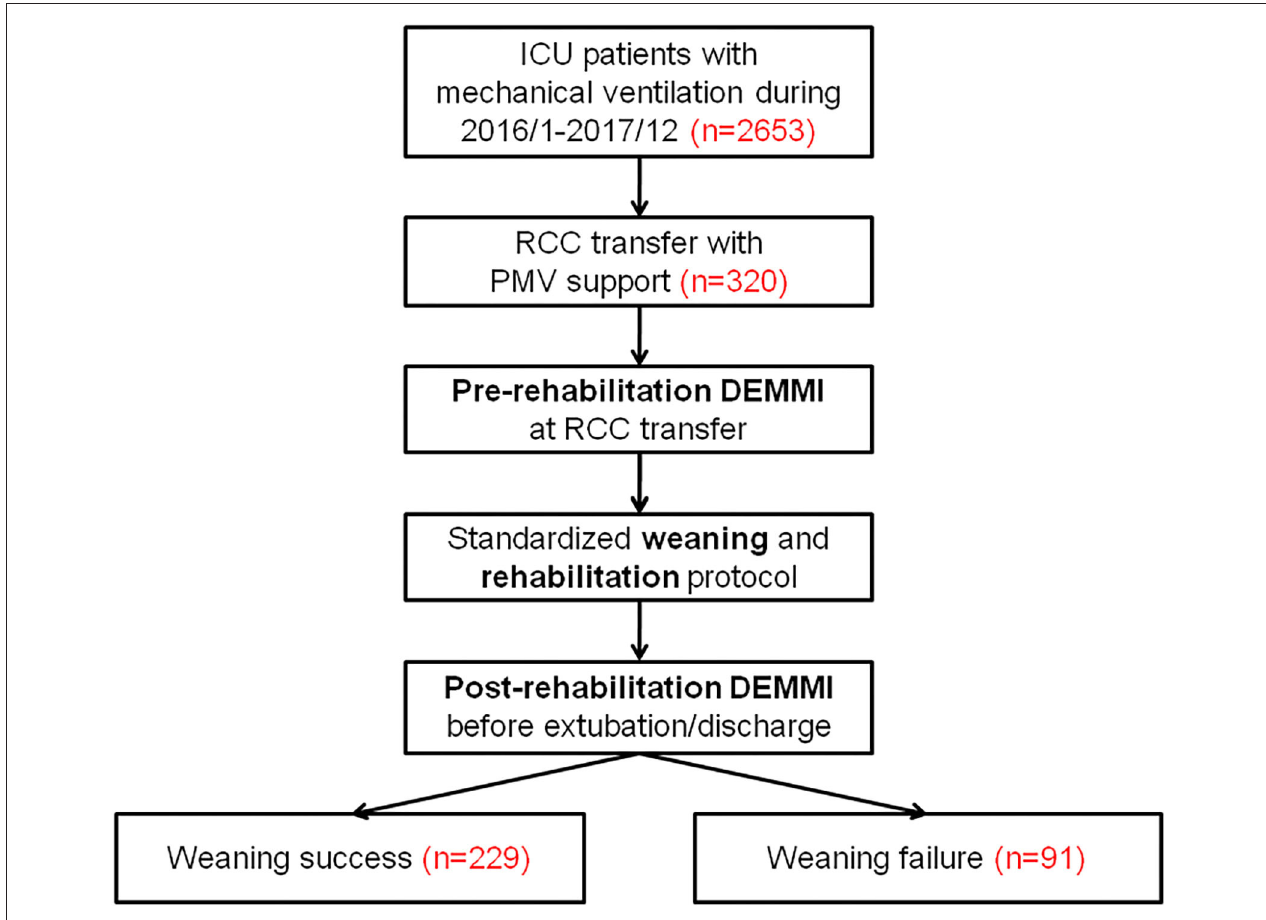
FIGURE 1 | The flow diagram of the study protocol. DEMMI, the de Morton Mobility Index; ICU, intensive care unit; PMV, prolonged mechanical ventilation; RCC, respiratory care center.